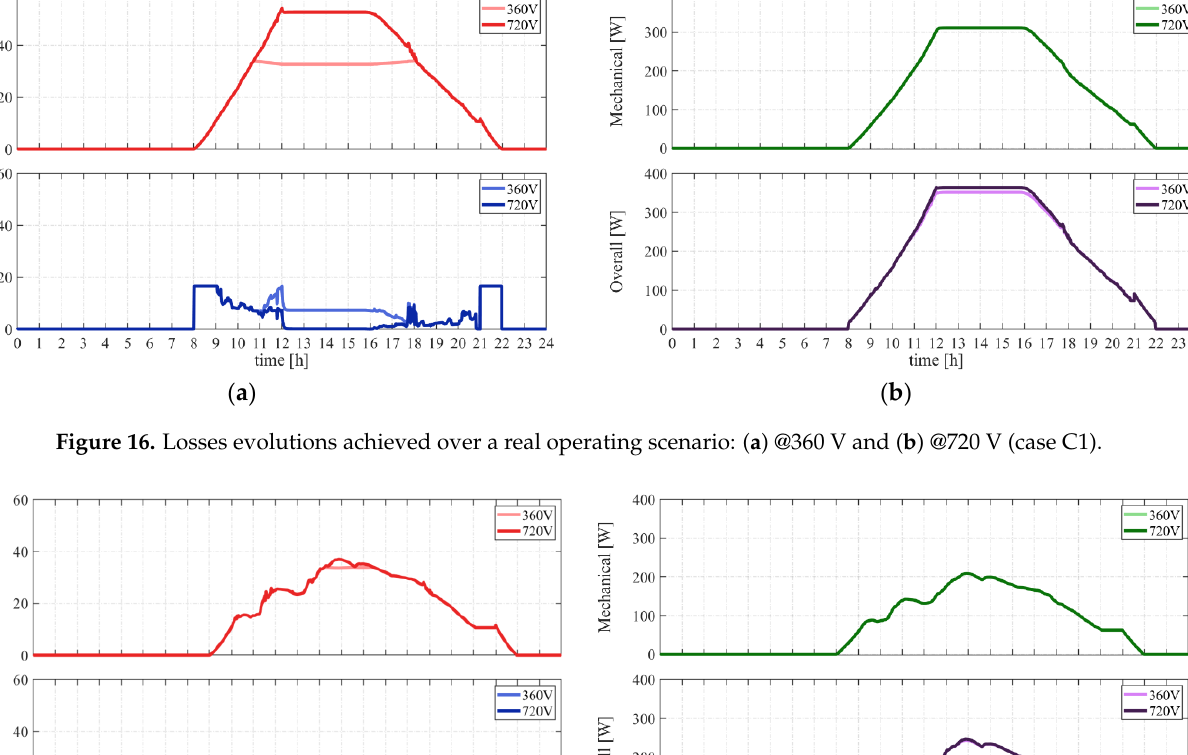
Figure 15. SOE and speed evolutions achieved over a real operating scenario @720 V: cases C1 ( a ) and C2 ( b ).